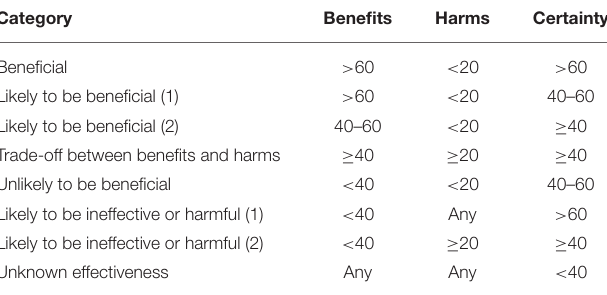
TABLE 1 | Effectiveness categories, defined by the median scores from the evidence assessment (based on Sutherland et al., 2017a). Category Benefits